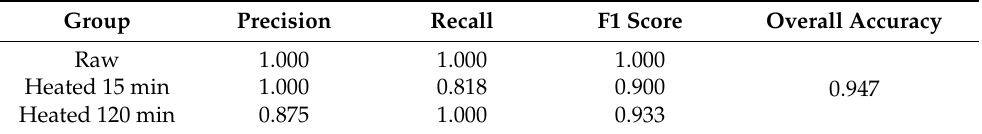
Figure 4. Discrimination of eucalyptus honey obtained by LDA of FTIR spectra based on analysis of the spectral range of 800–1500 cm − 1 . ( a ) Samples heated at 70 ◦ C. Achieved overall accuracy is 0.947. ( b ) Samples heated at 40 ◦ C. Achieved overall accuracy is 0.895. Dots: training set, triangles: test set. LD – linear discriminant. Table 3. Precision, recall, F1 score, and overall accuracy for raw and heated eucalyptus honey at 70 ◦ C for different heating times.